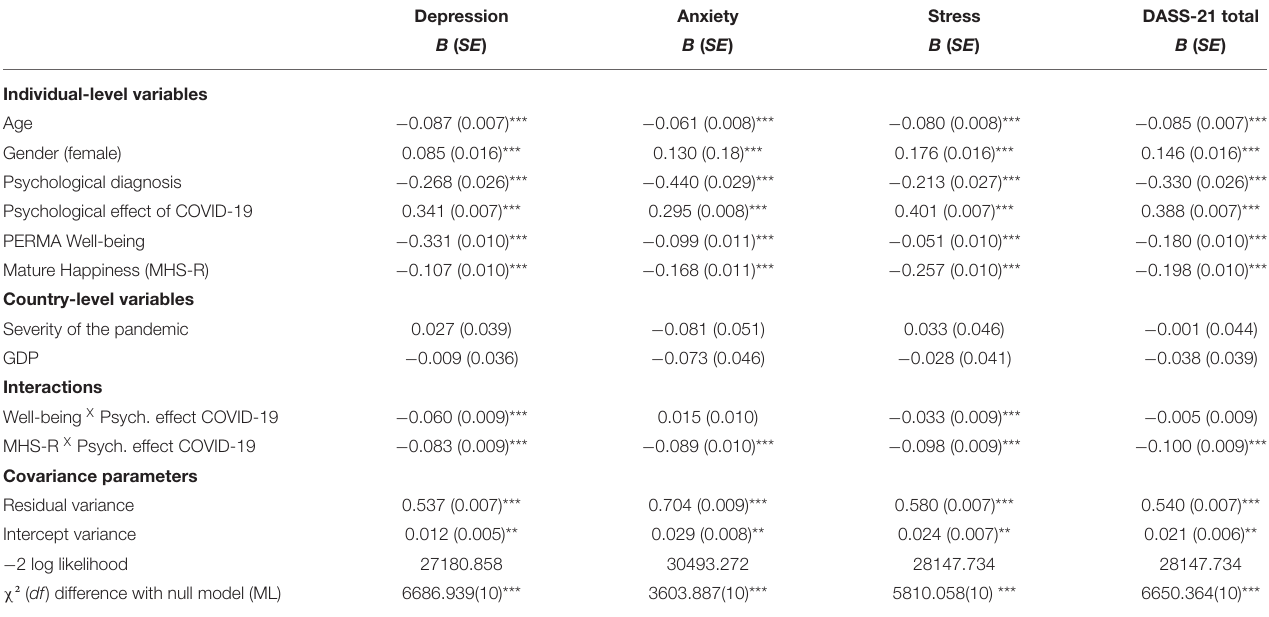
TABLE 4 | Multilevel modeling predicting markers of psychological problems. Depression Anxiety